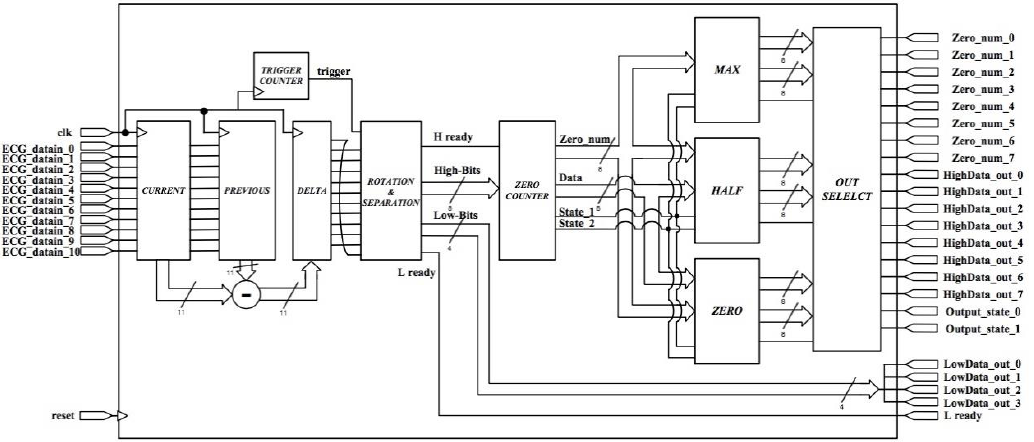
Figure 12. Xilinx ML505 field-programmable gate array (FPGA) evaluation board.